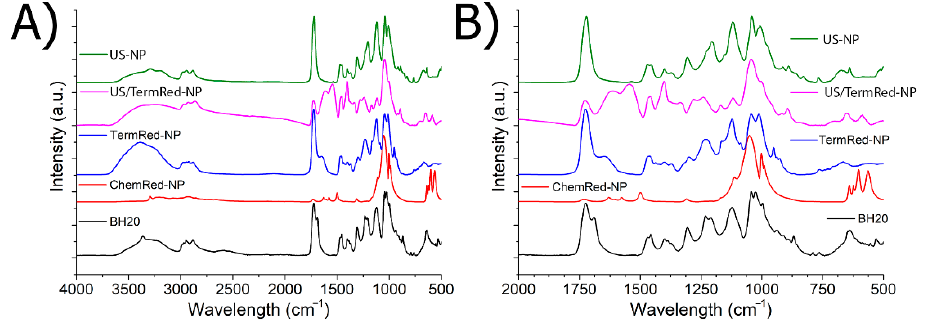
Figure 3. FT-IR spectra of hyperbranched polyester and samples ChemRed-NP, TermRed-NP, US/TermRed-NP, and US-NP: ( A ) full spectrum; ( B ) fingerprint area.